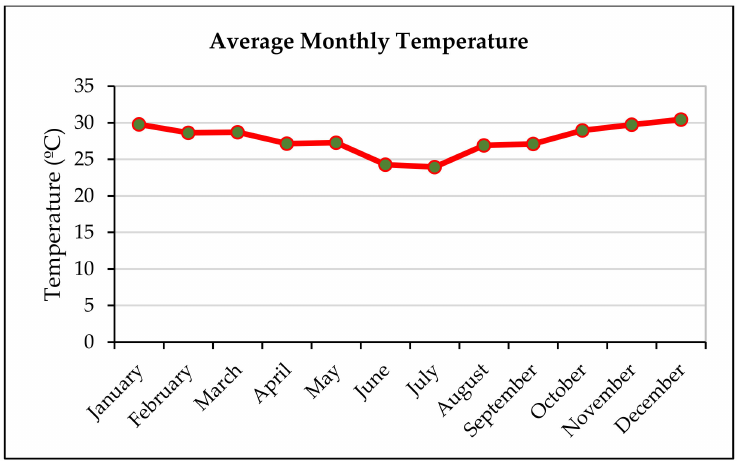
Figure 3. Average monthly ambient temperature between 1997 and 2010. Courtesy of HOMER [39].